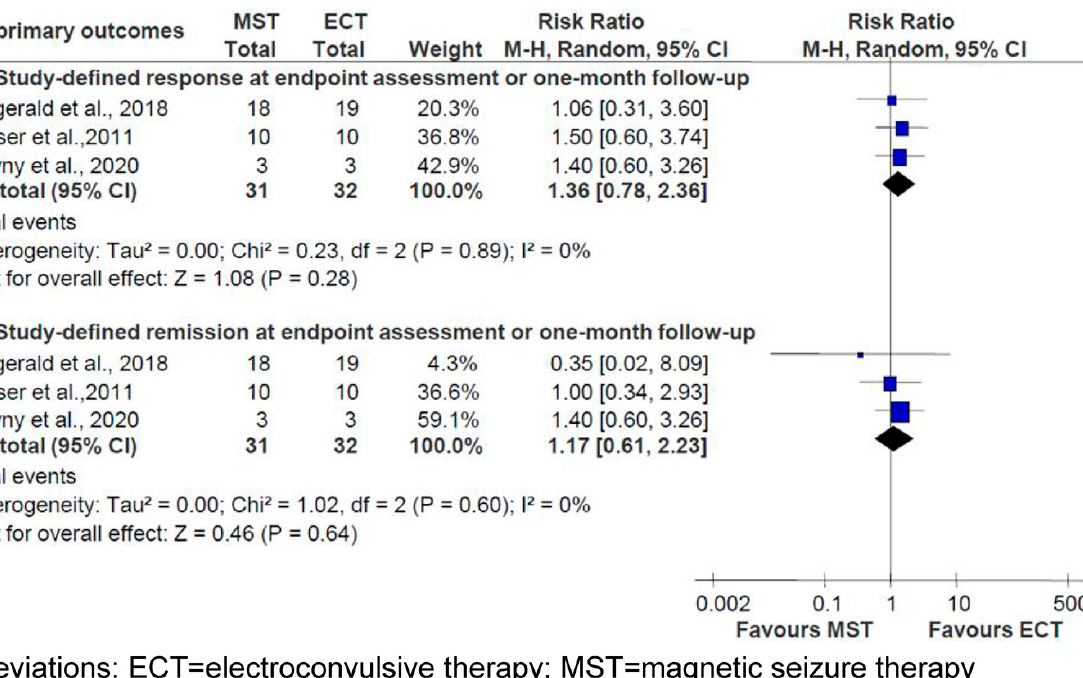
Figure 2. MST versus ECT for depression: forest plot for study-design response and remission.